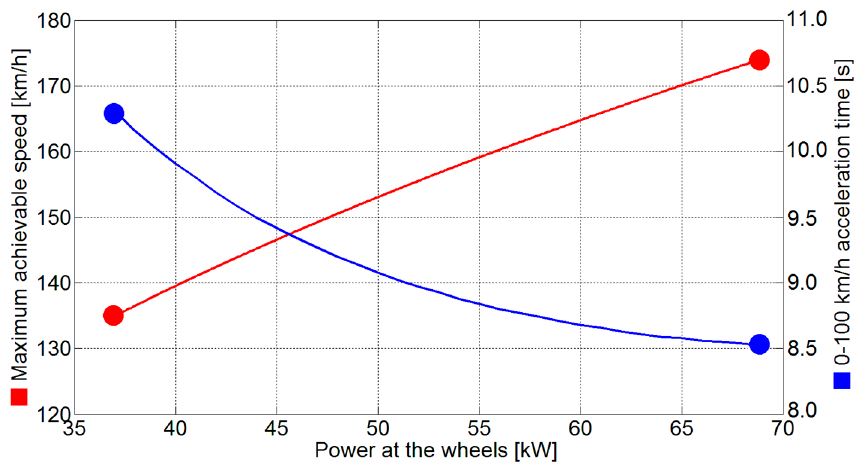
Figure 12. Maximum achievable speed and 0–100 km/h acceleration time as a function of power at the wheels.